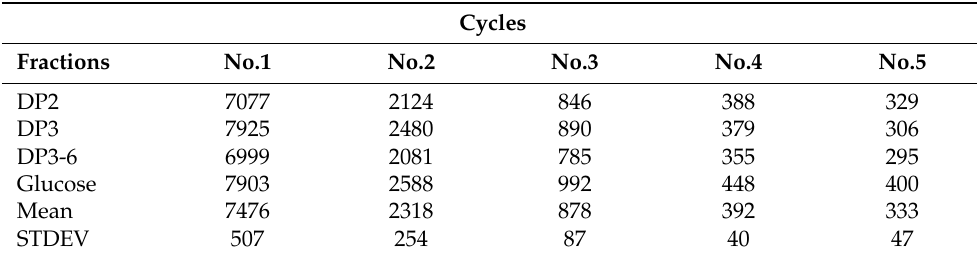
Table 4. Enzyme activity values [U · kg − 1 ] for the five consecutive cycles as determined by analyzing the reaction rates of different saccharides